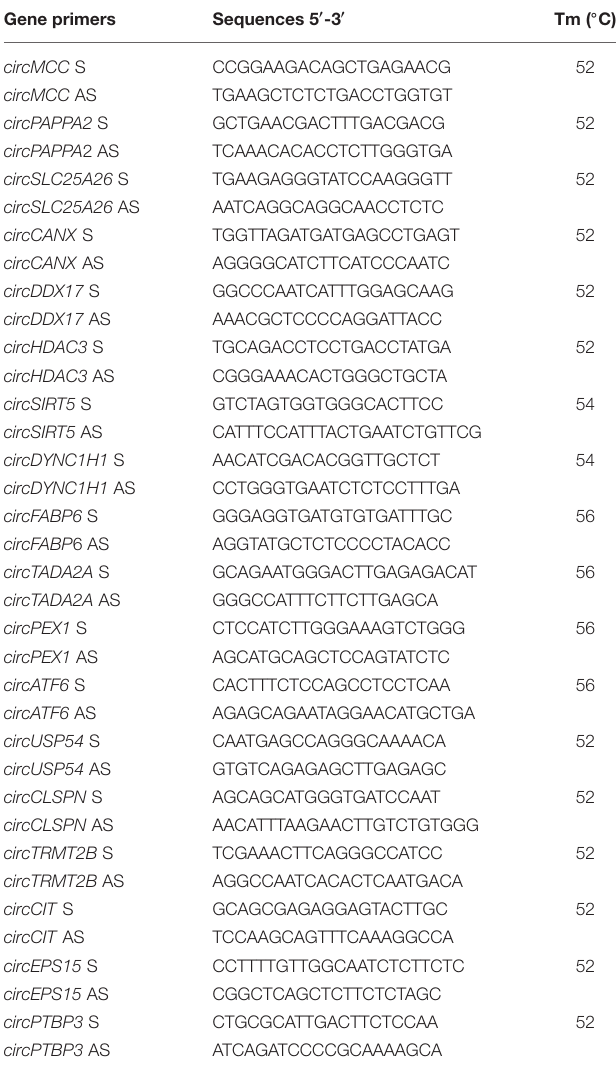
TABLE 2 | Primer sequences and annealing temperatures for